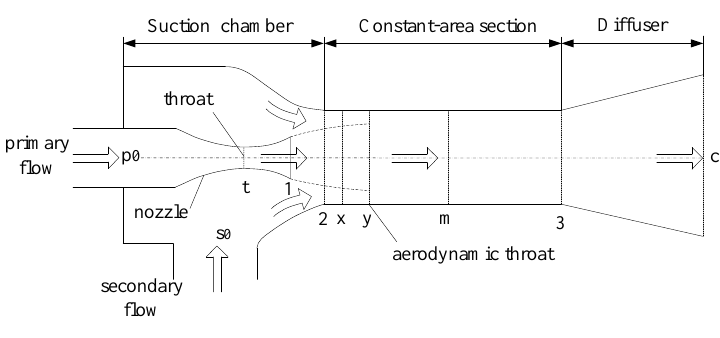
Figure 3. Schematic diagram of